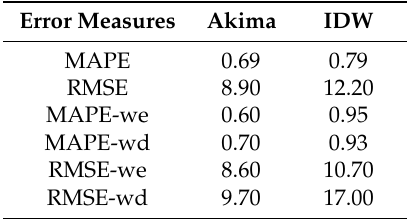
Table 2. Error measures vs. interpolation